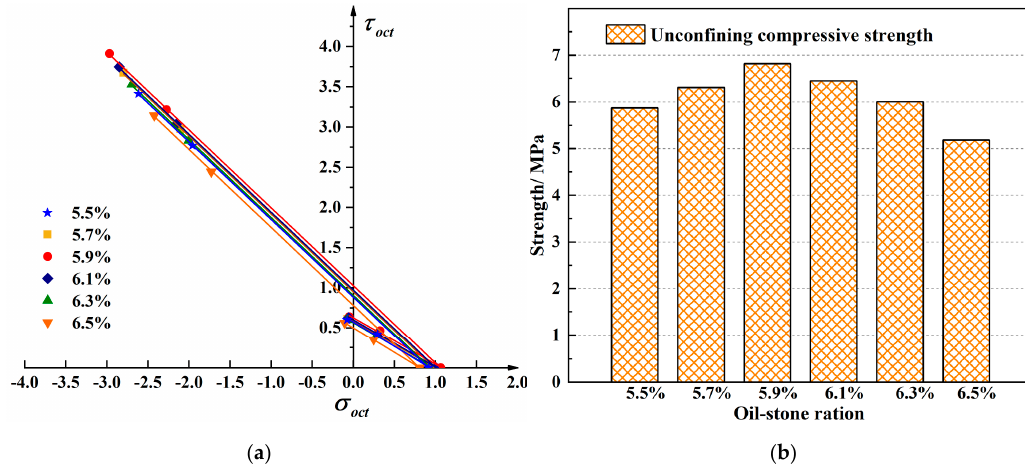
Figure 8. Linear compressive and tensile meridian under different oil-stone ratios. ( a )The compressive and tensile meridian under six different oil-stone ratios ( b ) The strength comparison between six different oil-stone ratios.